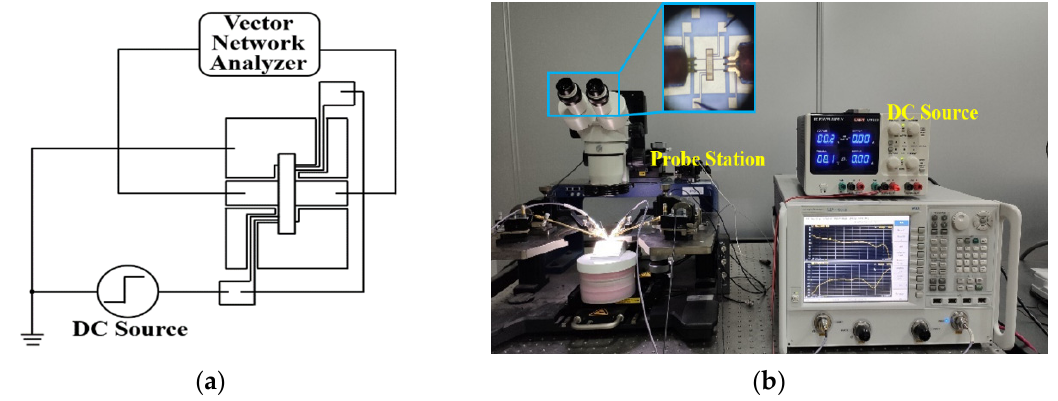
Figure 12. ( a ) Test circuit diagram for the microwave performance. ( b ) Test platform for the microwave performance.